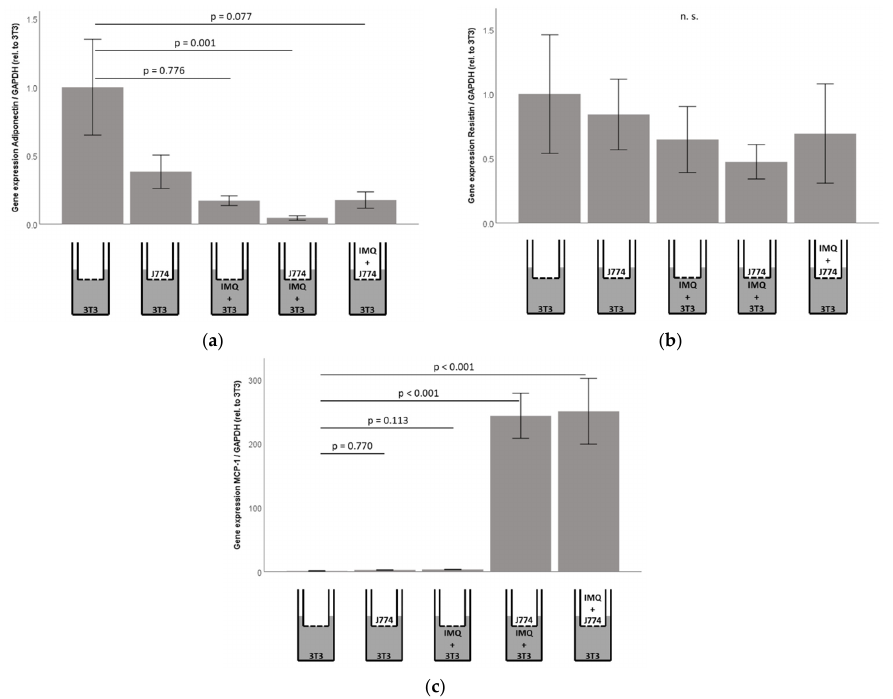
Figure A5. Imiquimod reduces adiponectin while increasing MCP1/CCL2 mRNA levels in 3T3-L1 adipocytes in co-culture with murine J774A.1 monocytes in vitro. Mature 3T3-L1 adipocytes were treated with IMQ (+IMQ) separately (3T3) and in co-culture (3T3 + J774) with J774A.1 monocytes as described in the Methods section for 18 h ( n = 7–12 wells each). After isolation of mRNA from the adipocytes applying the RNeasy ® Mini Kit (Qiagen, Hilden, Germany), gene expression levels of murine adiponectin, resistin and MCP1/CCL2 were quantified by reverse transcription and real-time PCR (RT-PCR) of the corresponding cDNA and normalized to GAPDH, as described in the Materials and Methods section. Remarkably, imiquimod significantly reduced ( a ) adiponectin while increasing ( c ) MCP1/CCL2 mRNA levels in adipocytes in co-culture with monocytes; ( b ) Resistin mRNA levels were not significantly affected. (n.s.—not